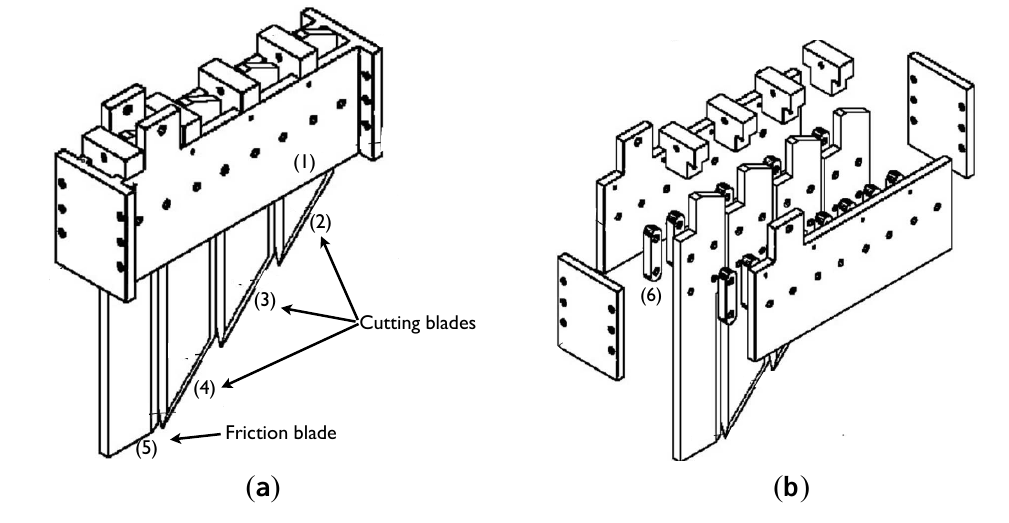
Figure 1. The soil strength profile